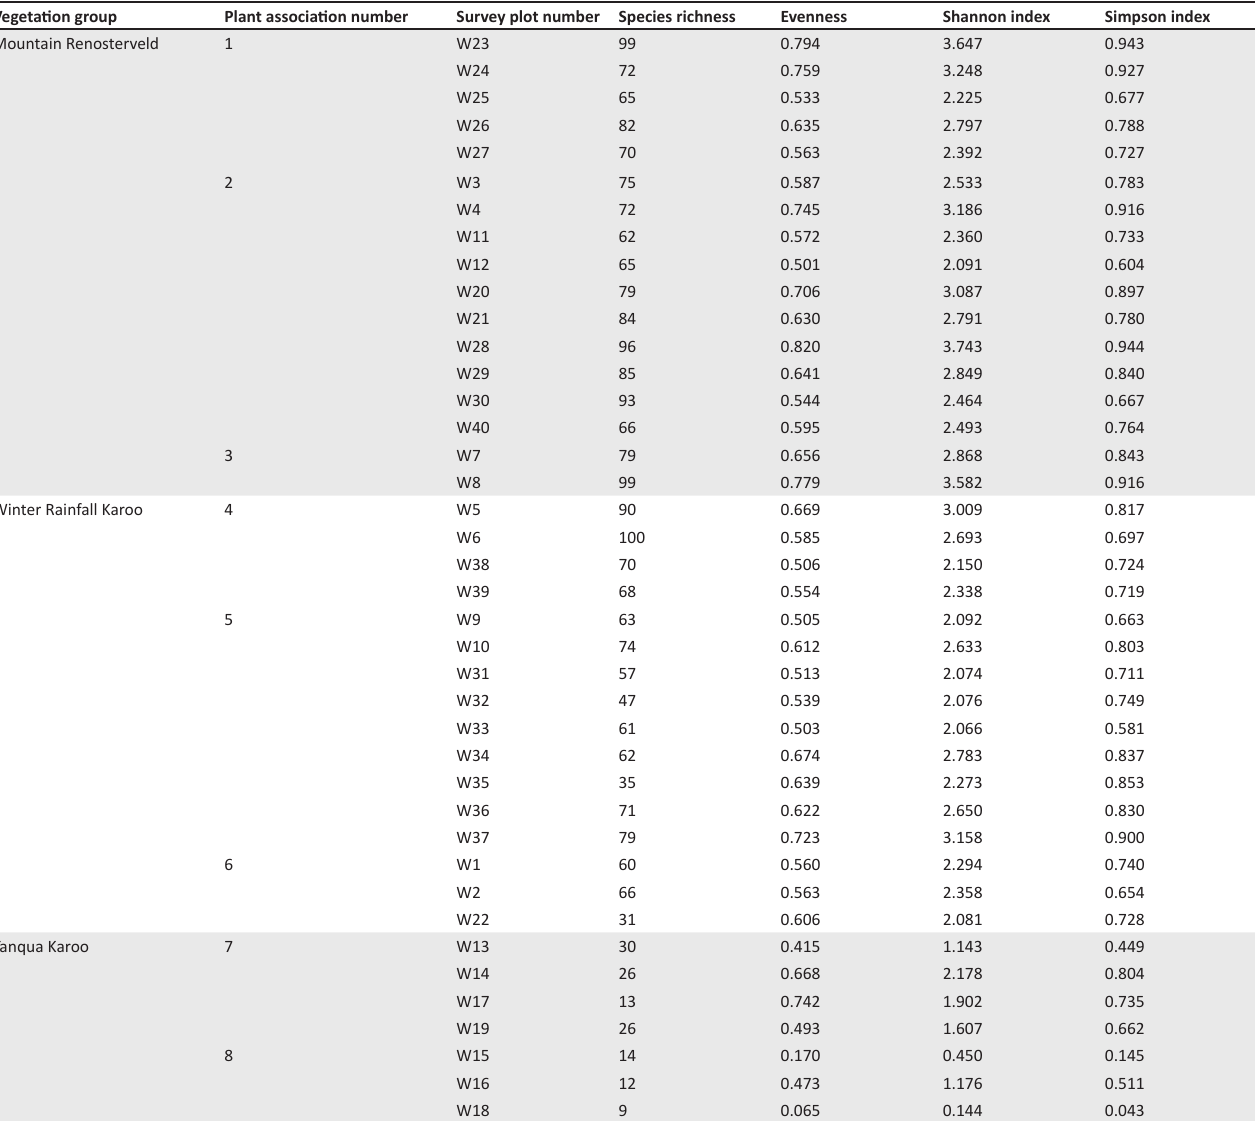
TABLE 1: Plant diversity parameters as determined for the different vegetation groups in the Hantam–Tanqua–Roggeveld subregion (spring of 2005). Vegetation group